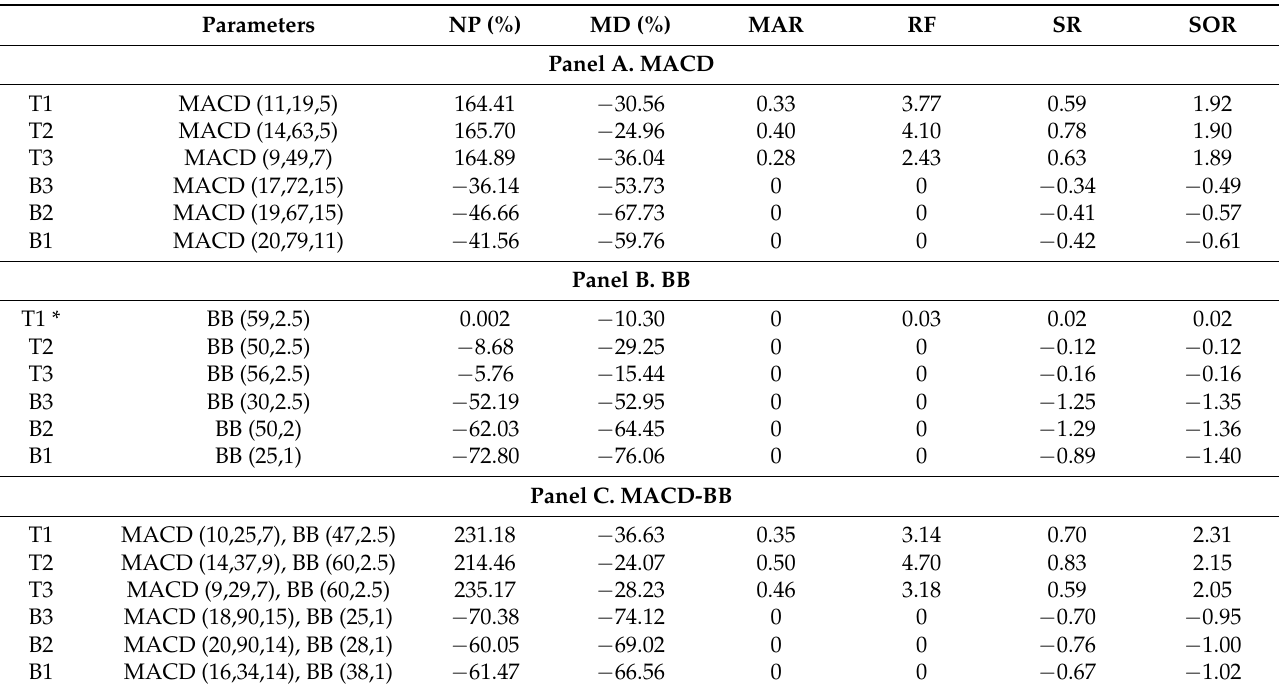
Table A1. Trading performance of non-fractal trading systems using different parameters.